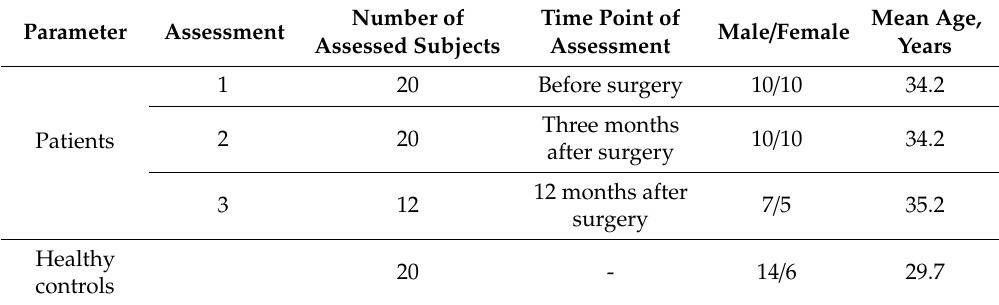
Table 1. Subject